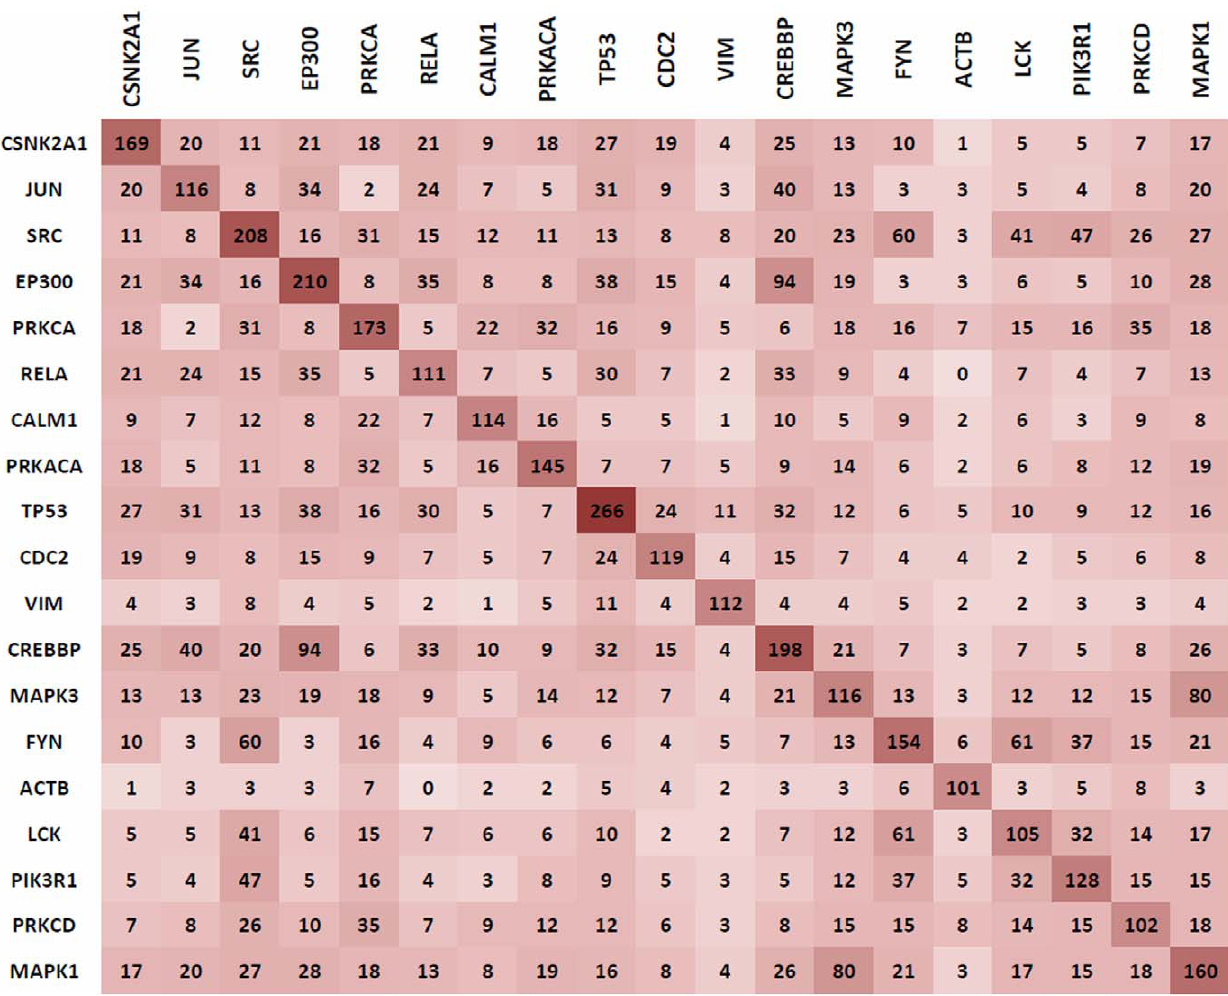
Figure 3. Heat map for common neighbors among hub proteins considered in the study. The number of common immediate neighbors between two hub proteins is show elements of a square matrix. Color intensity is proportional to the number of protein neighbors common to two hub proteins.